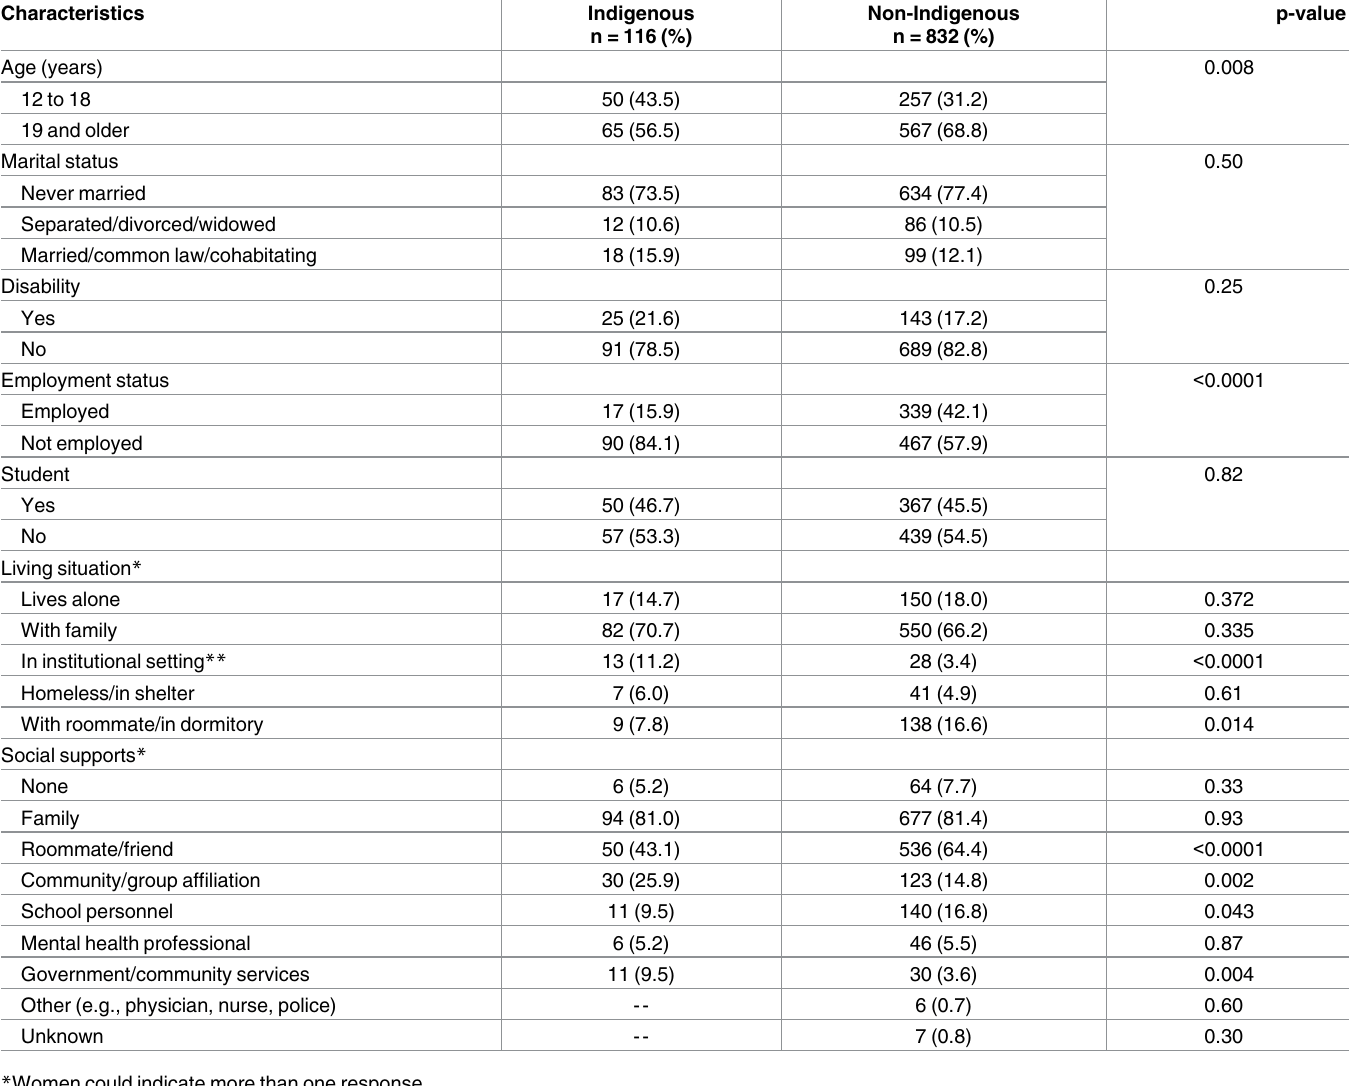
Table 2. Sociodemographic characteristics of sexually assaulted adolescent and adult women who presented to Sexual Assault/Domestic Vio- lence Treatment Centres, by Indigenous status.